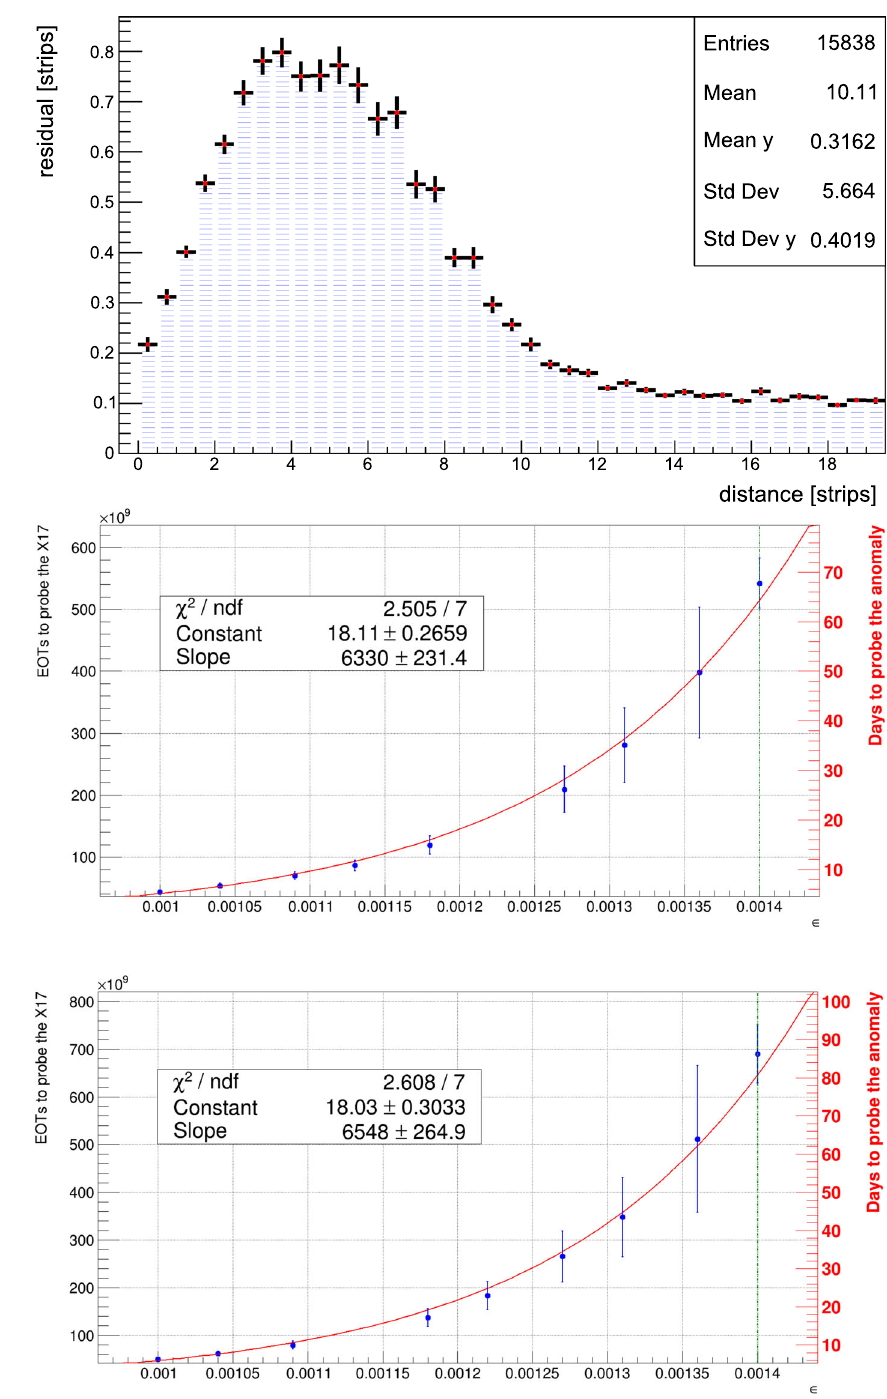
Fig. 13 Hit resolution of two separate clusters in a same plane as function of the distance between the two. The unit are given in strips size, where a single strip has a size of 256 µ m for the Micromegas used in the NA64 experiment. The hit resolution is calculated by mixing single clusters extracted from a low-intensity calibration run recorded in 2018